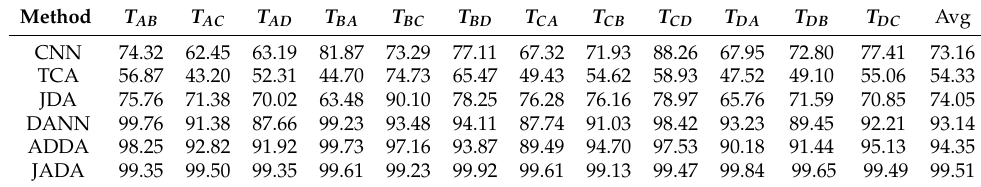
Figure 6. Classification accuracies of the different methods for the DDS dataset. Table 4. Classification accuracies of the different methods for transfer diagnosis tasks (%).